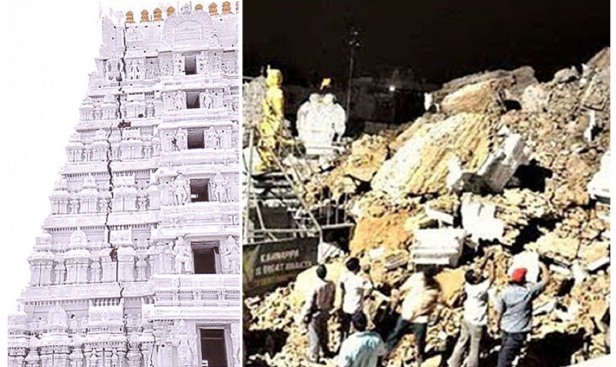
Figure 3 Gopuram before and after collapse (V.Sundaram,